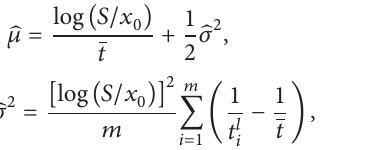
Figure 4: Simulation and true values.